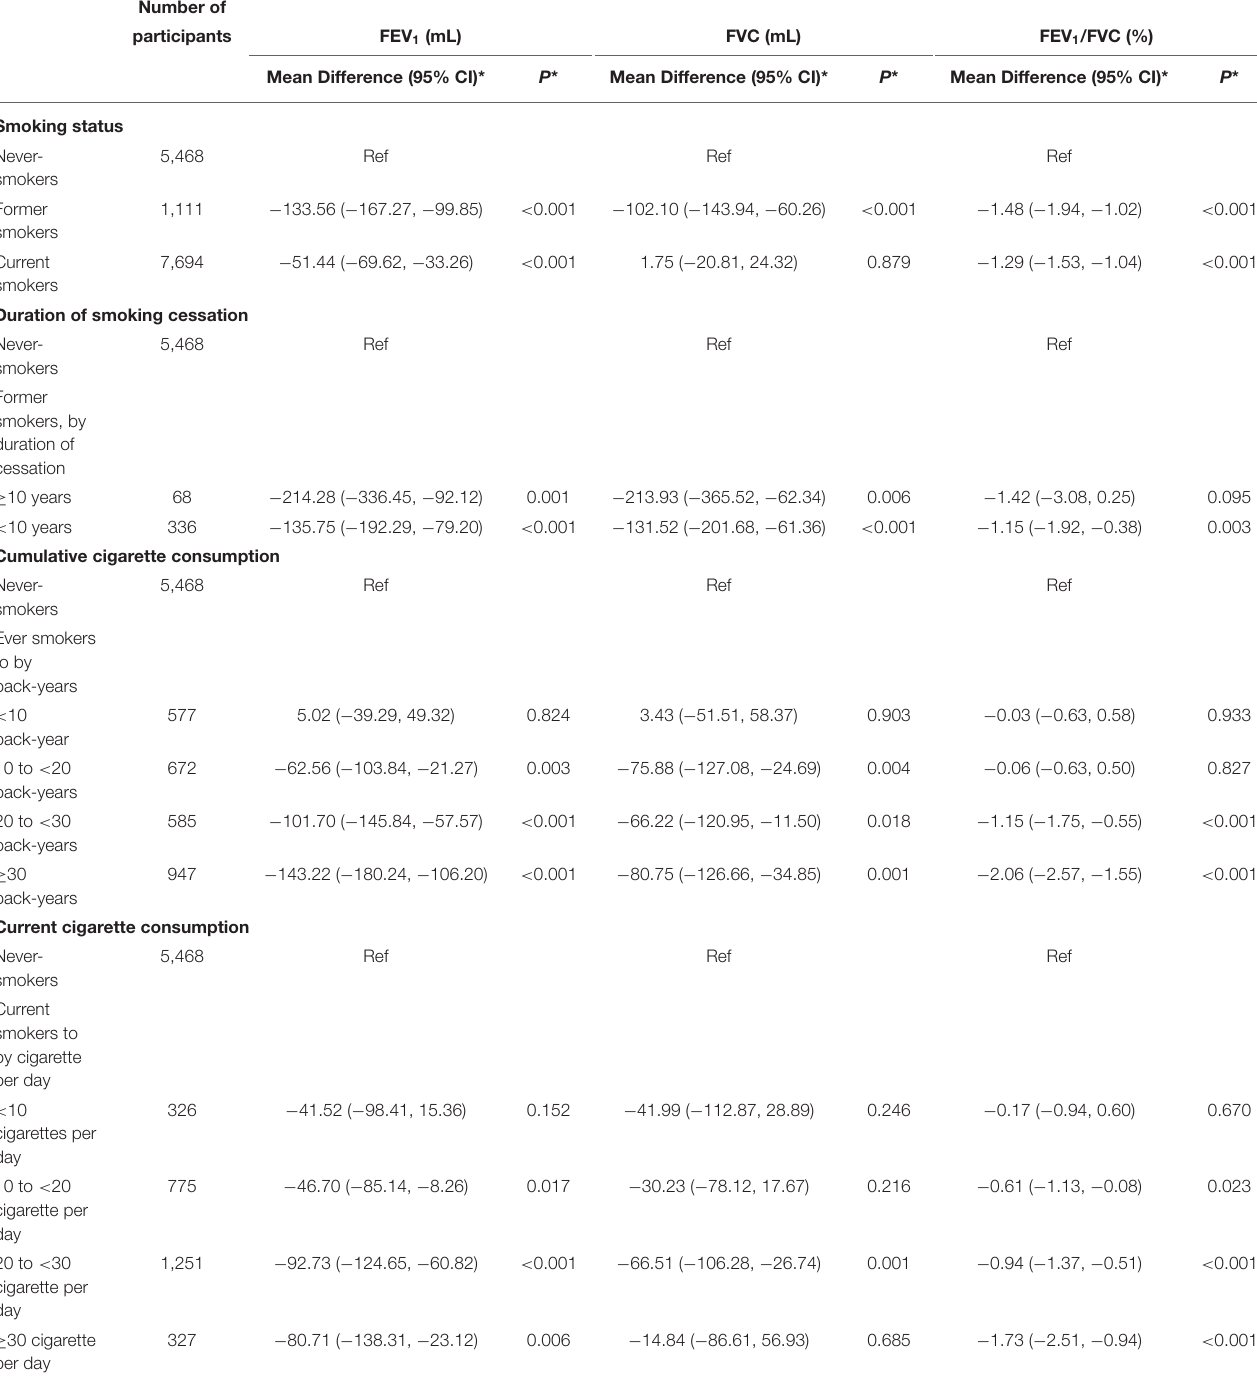
TABLE 2 | Cross-sectional associations of lung function and different smoking status at baseline. Number